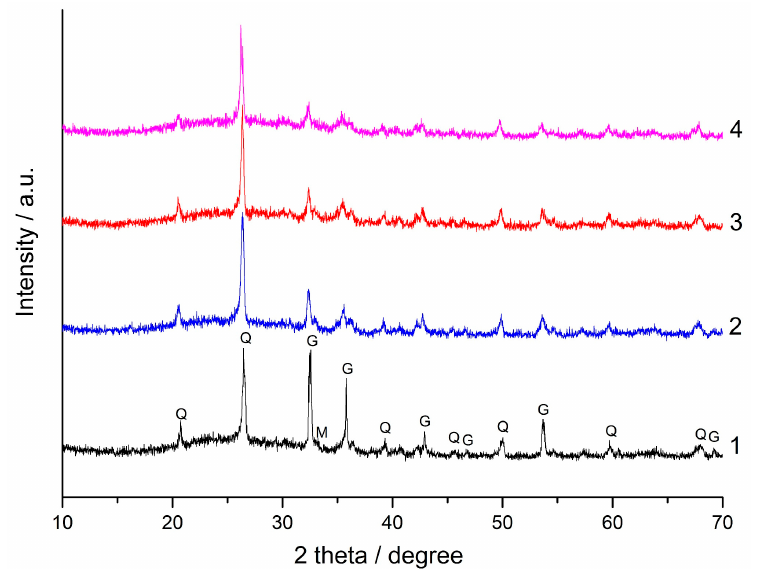
Figure 5. The XRD patterns: 1—the (90% FA + 10% magnesite) blend milled for 30 s, 2—the same blend milled for 180 s, 3 and 4—the geopolymer synthesized using this blend milled for 180 s after 7 d and 360 d of curing, respectively. Phases marked are: Q—quartz SiO 2 (ICDD 00-046-1045), M—mullite 3Al 2 O 3 · 2SiO 2 (ICDD 00-015-0776), G—magnesite MgCO 3 (ICDD 01-086-2348).